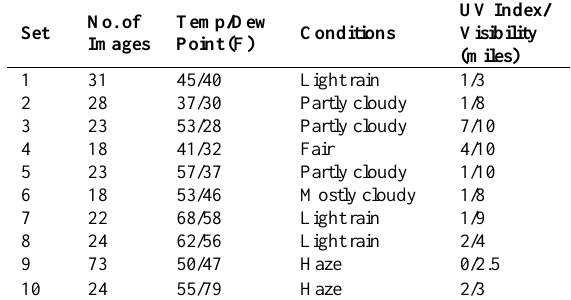
Table 1. Atmospheric index and weather conditions for 10 sets of OSU thermal images [29].